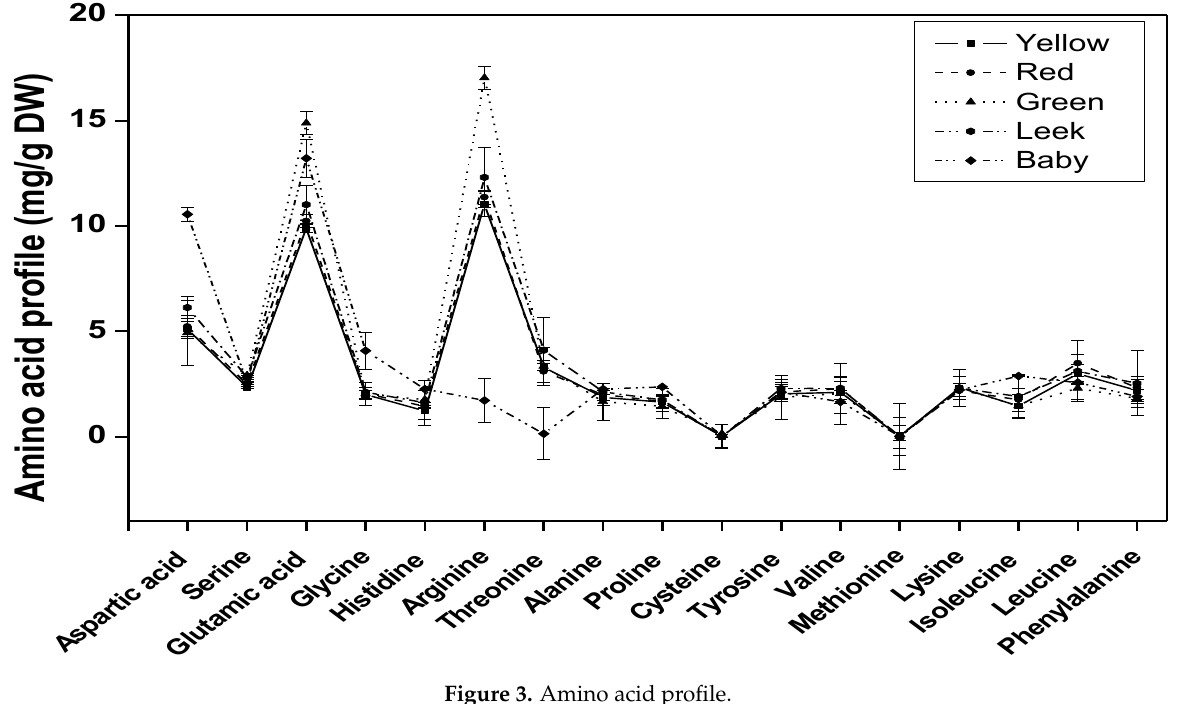
Figure 3. Amino acid profile.